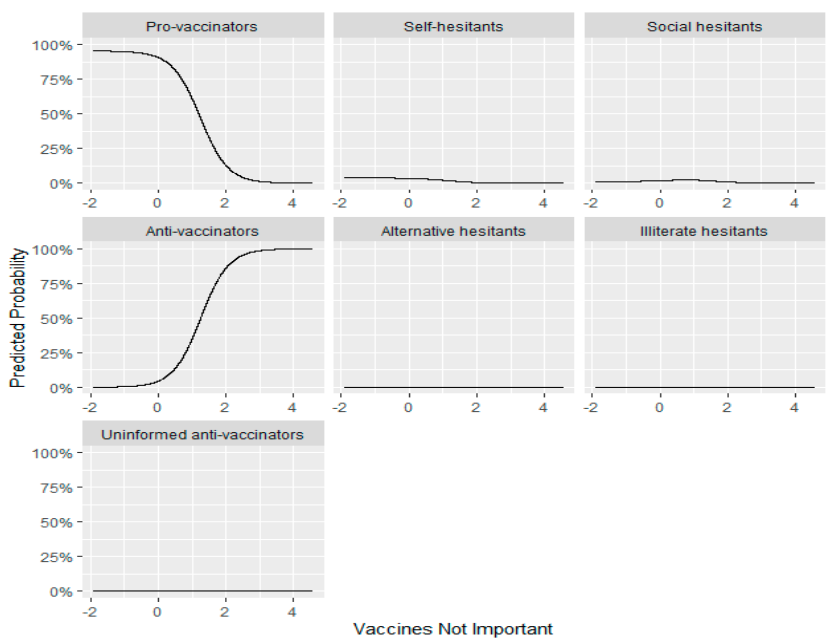
Figure A1. Marginal Effects Multinomial Logistic Regression. Vaccines Not Important.